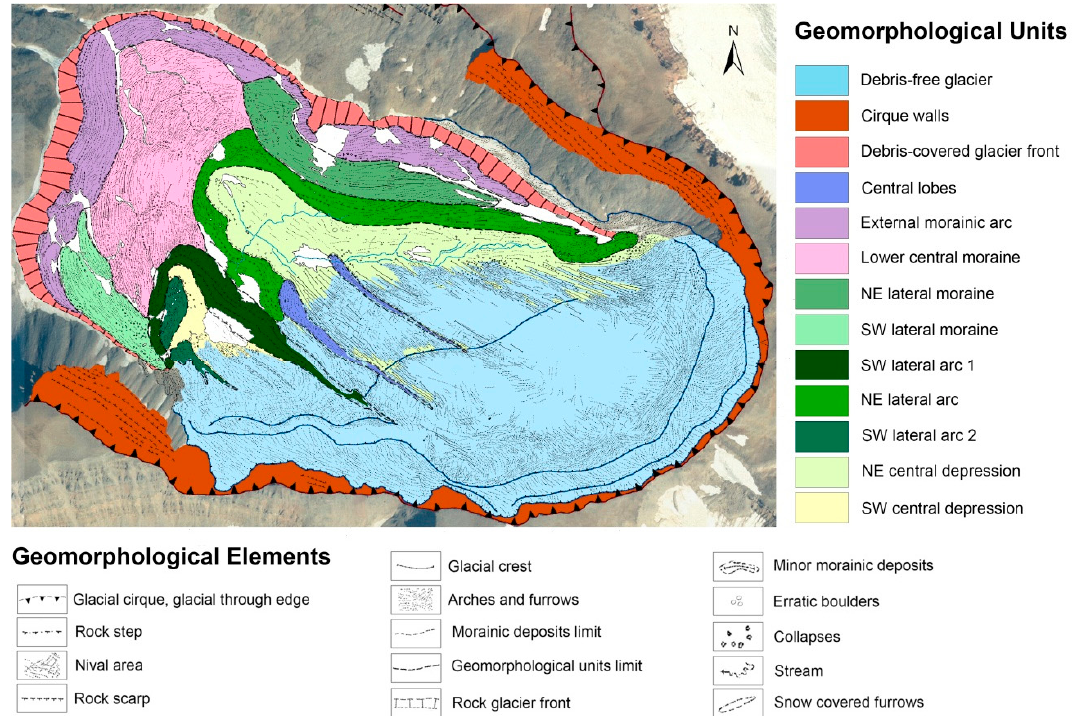
Figure 3. Part of a Geomorphological map of Hofsjökull debris-covered glacier (Tröllaskagi Peninsula, Iceland) from Campos et al. [36] (Adapted with permission from Elsevier). This map was created by combining traditional cartography and Geographical Information System techniques, preserving the ‘hand drawn’ elements and distinguishing the geomorphological units of the glacier area.